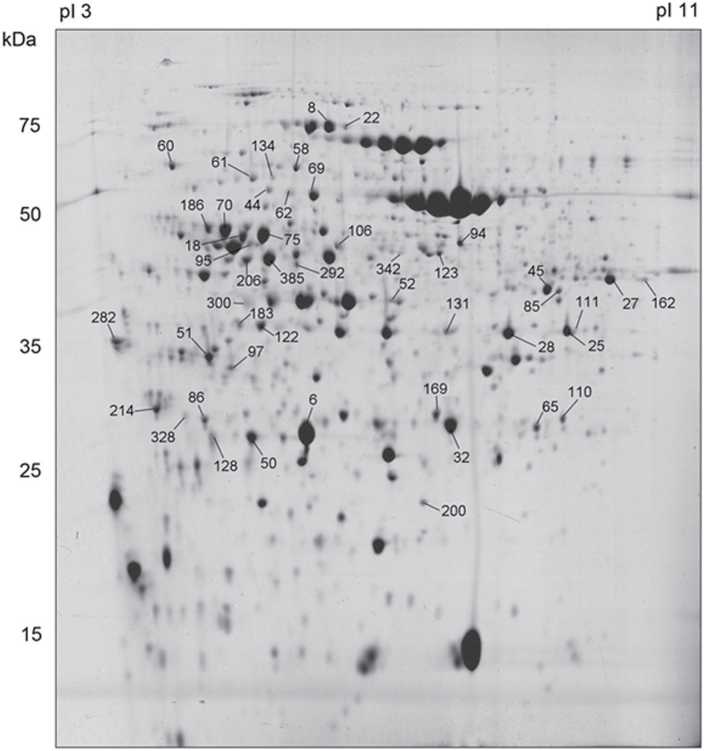
Preparative CBB-stained 2D gel of the soluble chloroplast proteome of Arabidopsis. The positions and numbers of the 47 identified protein spots are indicated according to the numbering in Table 3.